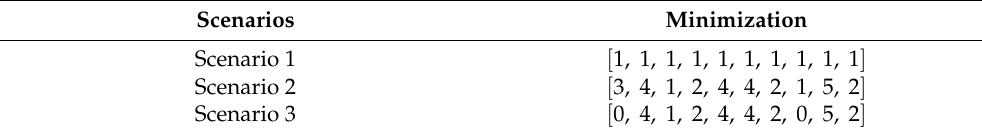
Table 6. Incidence rate vectors for Case Study #2.